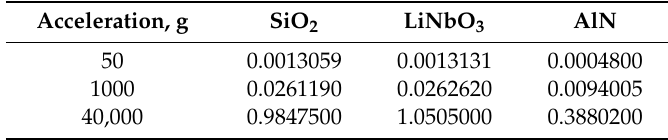
Table 2. Deformation of the console when using silicone adhesive ( µ m).